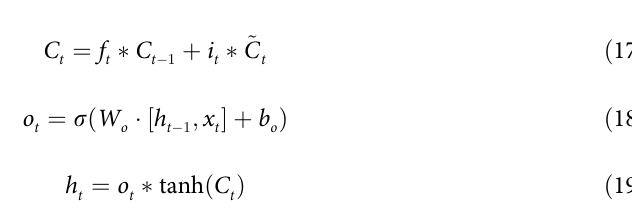
PLOS ONE | https://doi.org/10.1371/journal.pone.0282159 February 24,